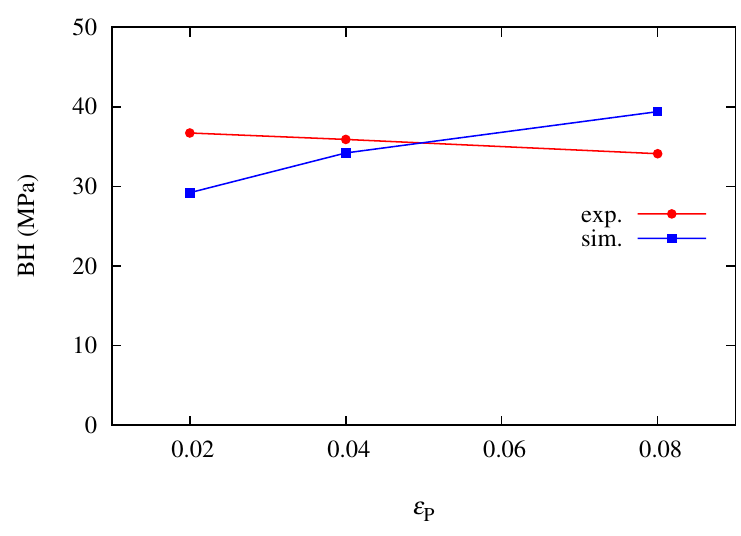
Figure 11. Comparison of the BH magnitude calculated from experimental and numerical